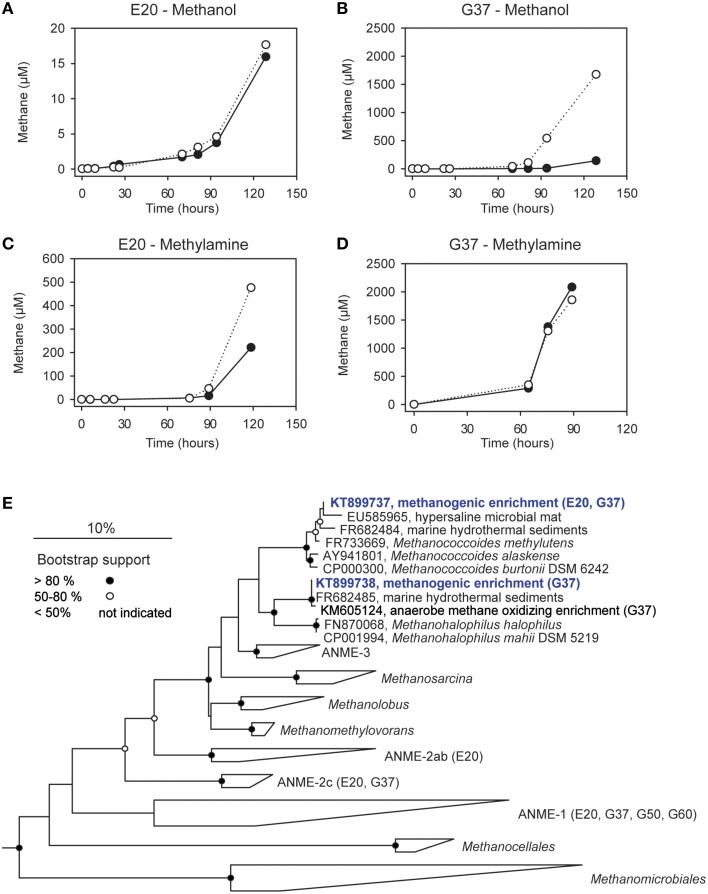
Methanogenesis and methanogenic archaea in AOM cultures. (A–D) Methane production in 1:10 dilutions of the E20 and G37 AOM enrichments after addition of methanol or methylamine (10 mM) to the enrichments; open and filled circles, two replicate incubations. (E) Phylogenetic affiliation of methanogens (blue) isolated in dilution-to-extinction approaches with methanol and methylamine.